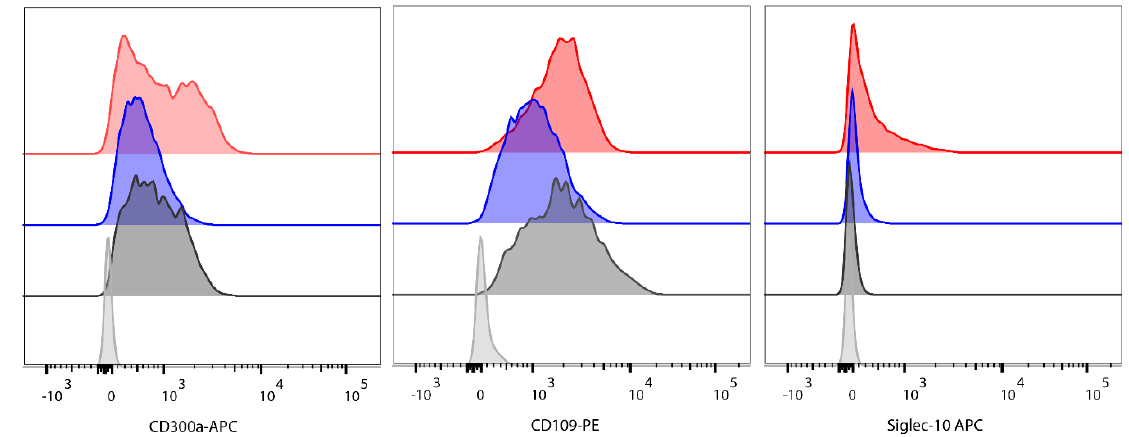
Figure 5. Validation of expression of novel polarisation markers in monocyte-derived macrophages (MDM). Peripheral blood monocyte-derived monocytes were differentiated to M Φ for 7 days and polarised with IFN γ + LPS or IL-4 for 48 h. Polarised MDM were stained for LILRB2, PILRA, CD300a, CD109, and Siglec-10 and analysed by FACS Canto. Representative of four independent donors. CD300a is an inhibitor of phagocytosis of apoptotic cells in M Φ [33]. Stimulation